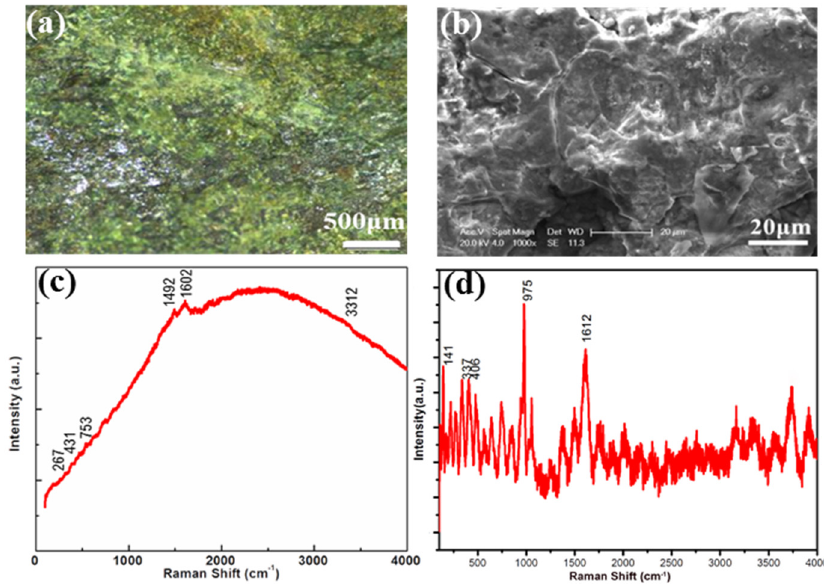
Figure 7. Characterizations of the corrosion products upon the bronze bowl ( Bo ) from the Tang Dynasty (Collection no.: 3668): ( a ) Optical image; ( b ) SEM morphology; ( c ) Raman spectrum of malachite in a range 100–3500 cm − 1 ; ( d ) Raman spectrum of brochantite in a range 100–3500 cm − 1 .